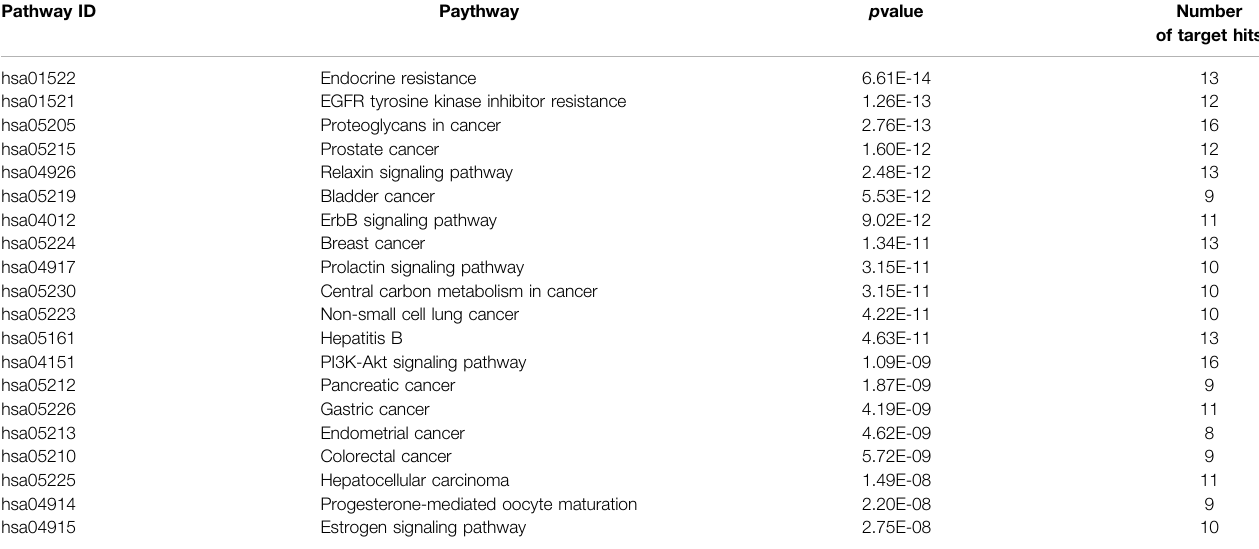
TABLE 2 | Kyoto Encyclopedia of Genes and Genomes pathway analysis for the treatment of non-small cell lung cancer, using R software. Pathway